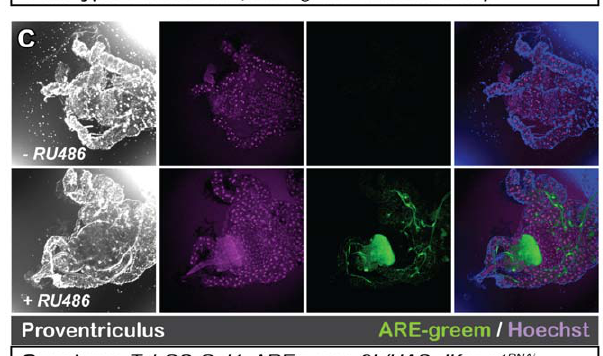
Figure 3. ARE and TRE reporters faithfully reproduce known patterns of JNK and Nrf2 signaling. A. The TRE-red reporter marks the leading edge cells of stage 13 to 15 embryos where JNK is known to be active during dorsal closure. In addition to the TRE-red-2R reporter, the embryos expressed a moesin GFP fusion protein (sGMCA [47]) to visualize the actin cytoskeleton (green). Three embryos at progressively later stages of dorsal closure are shown. B. ARE-green reporter activity was detected in different larval tissues in which Nrf2 function has previously been reported [24]. In 3 rd instar larval salivary glands Nrf2 reporter activity was undetectable at basal levels (top panel, genotype TubGSGal4, ARE-green-2L/UAS-dKeap1 RNAi , no RU 486 treatment), but was prominent after knockdown of Keap1 expression (same genotype as above, but keap1 RNAi expression was induced by RU486). The nuclei are stained with Hoechst (purple). The left panels show a micrograph of the salivary glands. C. Cells in the proventriculus of the digestive tract show prominent Nrf2 activity after Keap1 knockdown. Conditions and genotypes are as described in panel B.